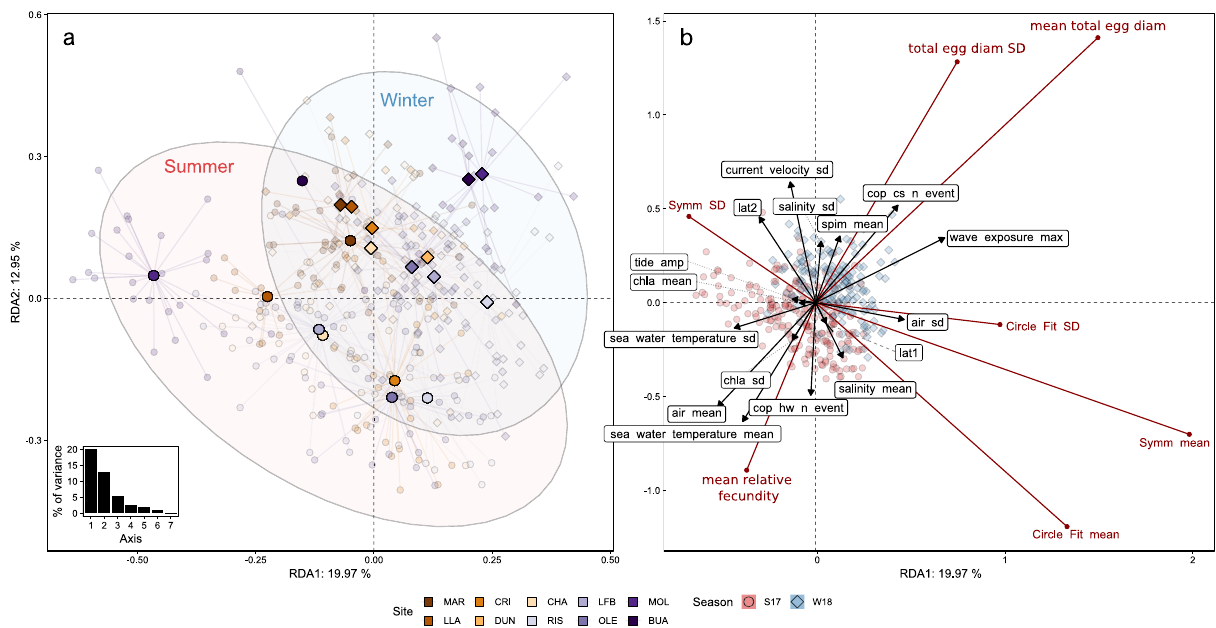
Figure 4. Redundancy analysis (RDA) of selected centered and standardized within-clutch reproductive traits. Reproductive traits are displayed as red vectors in the right-hand ( b ); (Scaling 2) constrained by selected standardized environmental variables (displayed as black vectors ( b ); Scaling 2). The left-hand ( a ) shows the centroid scores for each sampling site and season, linked to each individual (Scaling 1). 95% confidence dispersion ellipses are represented for the seasons. In both panels, summer scores are displayed by circles, winter scores as diamonds and colors correspond to the sampling sites. Axes values represent the % of explained variance per axis, the two axes representing altogether 33% of the total variance. The inner figure of ( a ) corresponds to the eigenvalues of the first 7 RDA axes. ( b ) Environmental variable abbreviations are as follows: ‘spim mean’ = mean suspended particulate inorganic matter; ‘lat1’ = linear latitude; ‘lat2’ = quadratic latitude; ‘chla’ = chlorophyll- a ; ‘tide amp’ = mean tidal amplitude; ‘cop cs n event’ = number of cold spells in seawater over 30 days; ‘cop hw n event’ = number of heatwaves in seawater over 30 days; ‘air mean’ = air temperature mean. All ‘sd’ suffixes represent the variation (standard deviation) of different variables. Site abbreviations as for Fig.